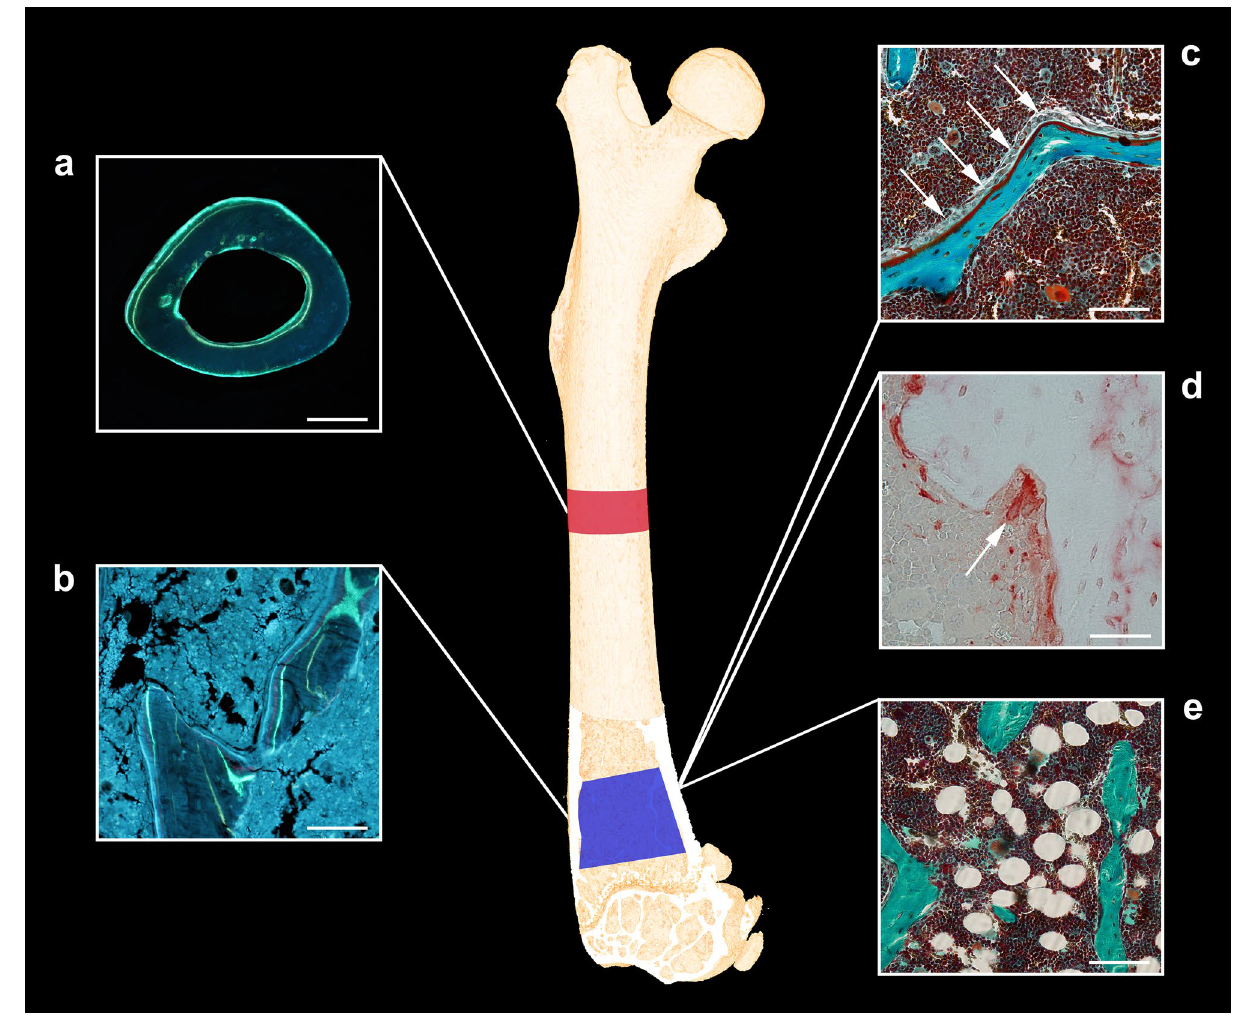
Figure 2. ( a ) Dynamic bone histomorphometry at the femoral mid-diaphysis. Bar = 0.5 mm. ( b ) Dynamic bone histomorphometry at the distal femoral metaphysis. Bar = 50 μm. ( c ) Osteoblasts (white arrows) residing on red osteoid at the distal femoral metaphysis. Masson–Goldner trichrome. Bar = 50 μm. ( d ) TRAP-stained osteoclast in a Howship’s lacuna at the distal femoral metaphysis. Bar = 100 μm. ( e ) Unilocular adipocytes in the bone marrow at the distal femoral metaphysis. Masson–Goldner trichrome. Bar = 50 μm.